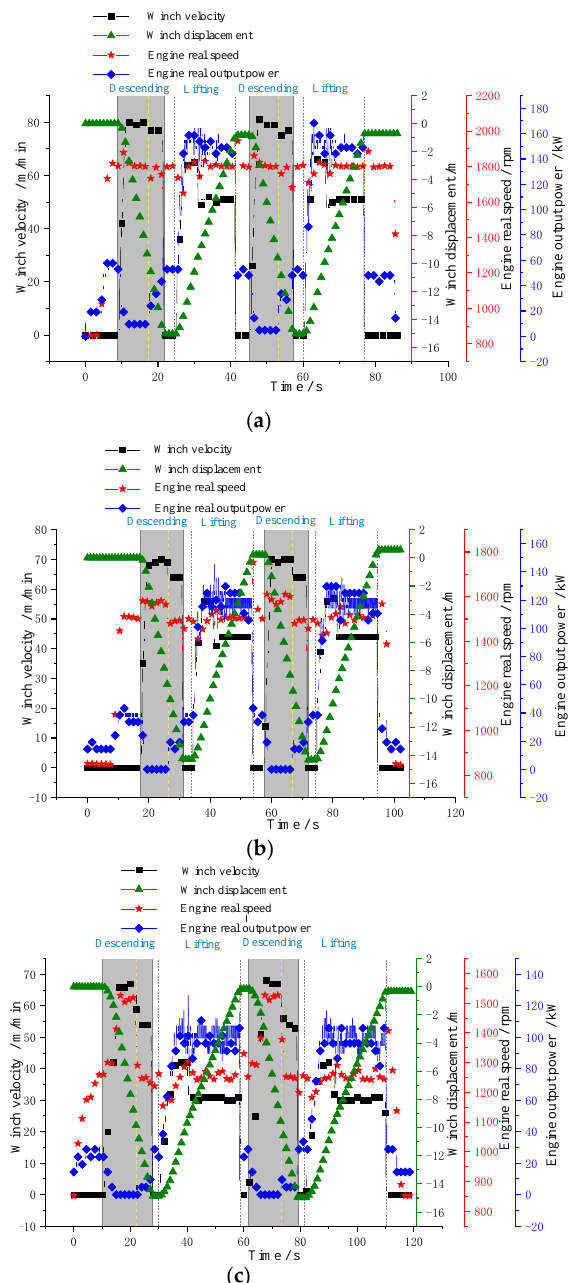
Figure 8. Characteristic curves under different engine speeds. ( a ) Engine speed and power, winch displacement and velocity under Condition 1; ( b ) Engine speed and power, winch displacement and velocity under Condition 2; ( c ) Engine speed and power, winch displacement and velocity under Condition 3.